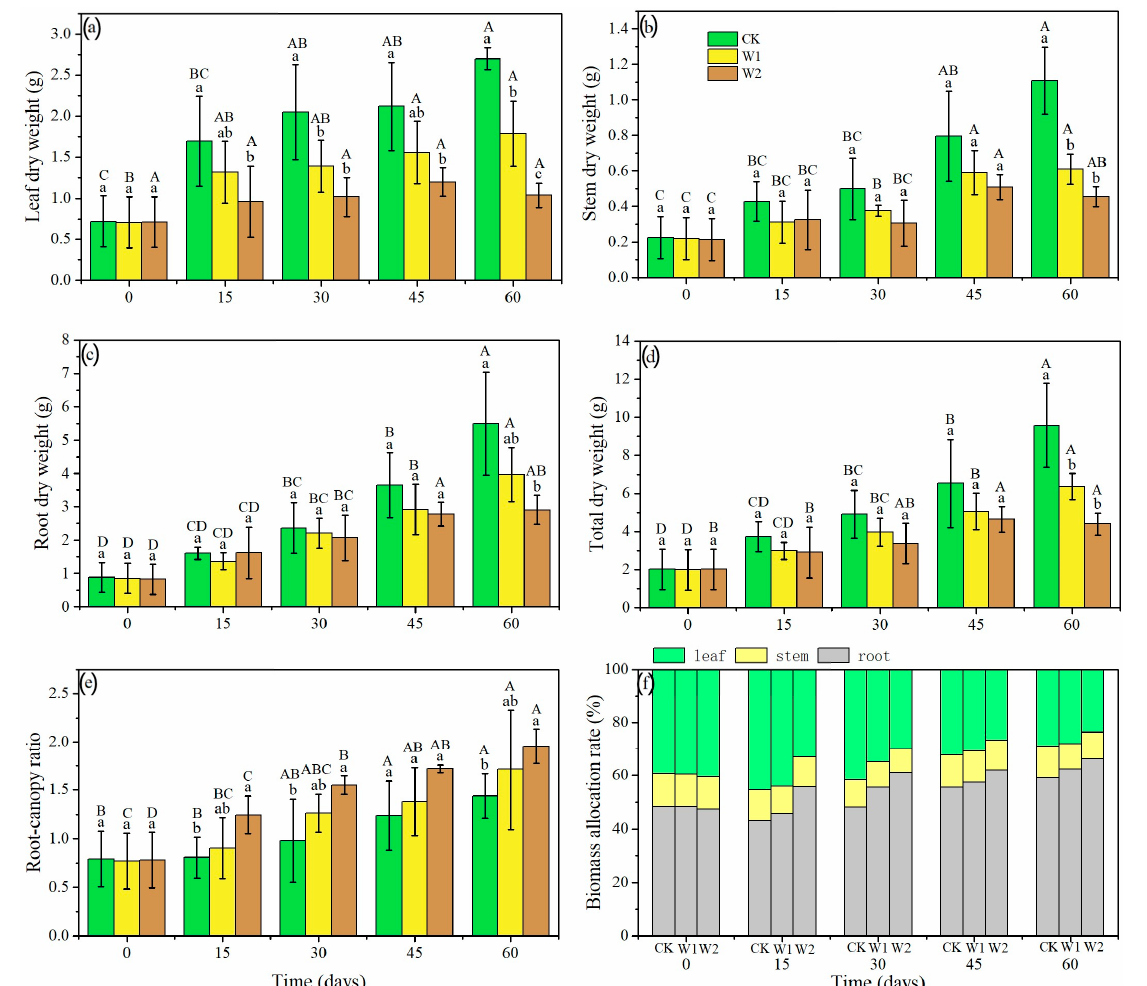
Figure 5. Leaf dry weight ( a ), stem dry weight ( b ), root dry weight ( c ), total dry weight ( d ), root: shoot ratio ( e ), and biomass allocation rate ( f ) of Mongolian oak seedlings under different drought intensities and durations. Uppercase letters represent the significant differences in the same treatment at different times ( p < 0.05), and lowercase letters represent the significant differences between different treatments at the same time ( p <